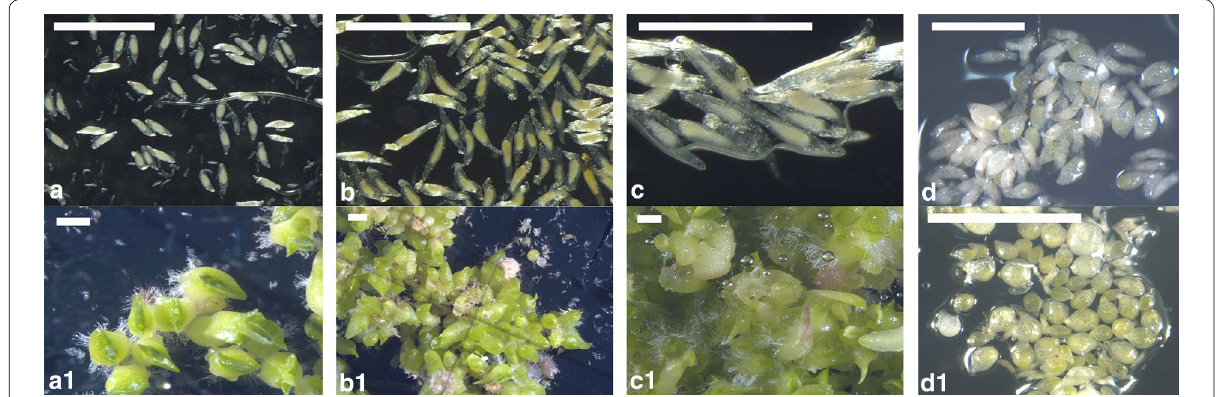
Fig. 5 Light microscope images of in vitro collected seeds on in vitro germination medium a Angraecum magdalenae ; b Angraecum calceolus ; c Angraecum rutenbergianum ; d Angraecum rhynchoglossum ( scale bar 500 µm). The lower row ( a1 – d1 , scale bar 1 mm) shows protocorms of in vitro collected